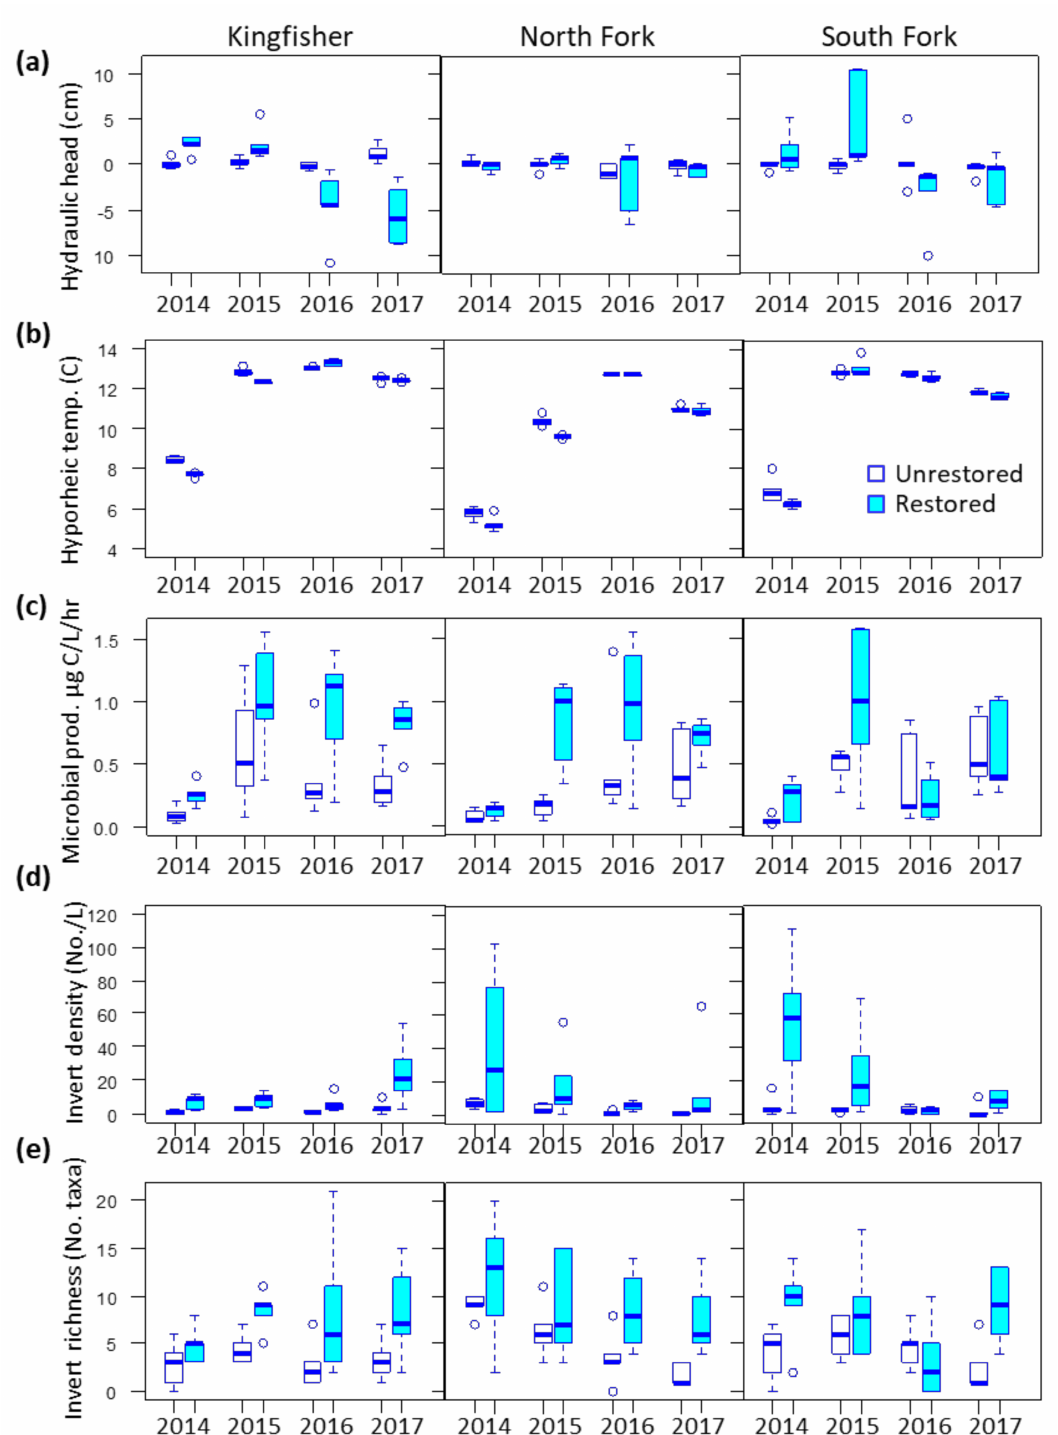
Figure 2. Boxplots of univariate response metrics plotted by site, restoration status, and year for ( a ) hydraulic head ( b ), hyporheic temperature ( c ) microbial heterotrophic production ( d ) hyporheic invertebrate density, and ( e ) hyporheic invertebrate taxa